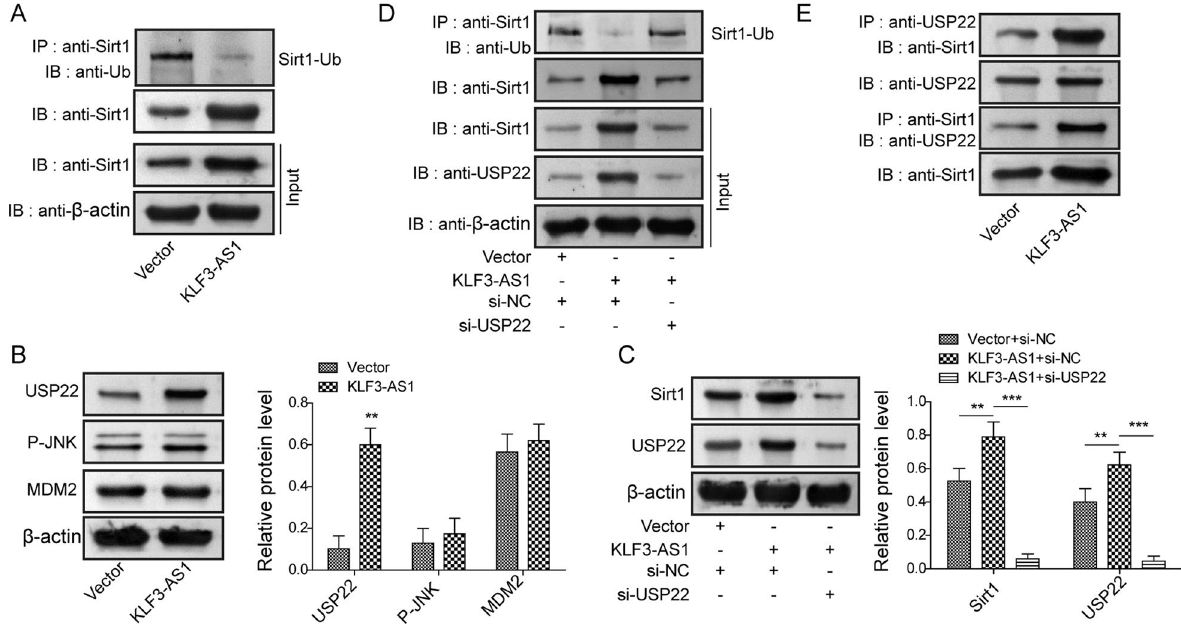
Fig. 4 USP22 silencing antagonized the effect of KLF3-AS1 on Sirt1 deubiquitination. A , B BV-2 cells were transfected with KLF3-AS1 overexpression plasmid or vector, Sirt1 ubiquitination was evaluated by Co-immunoprecipitation ( A ), then protein expressions of USP22, MDM2 and P-JNK were tested ( B ). Cells were transfected with pcDNA-KLF3-AS1 or sh-USP22, then Sirt1 and USP22 proteins were detected by western bolt ( C ), and Sirt1 deubiquitination was assessed by Co-immunoprecipitation ( D ). E Cells were transfected with KLF3-AS1 overexpression plasmid or vector, the interaction between USP22 and Sirt1 was then validated by Co-immunoprecipitation. Values were expressed as mean determinations in the in vitro assays. **P < 0.01, ***P <